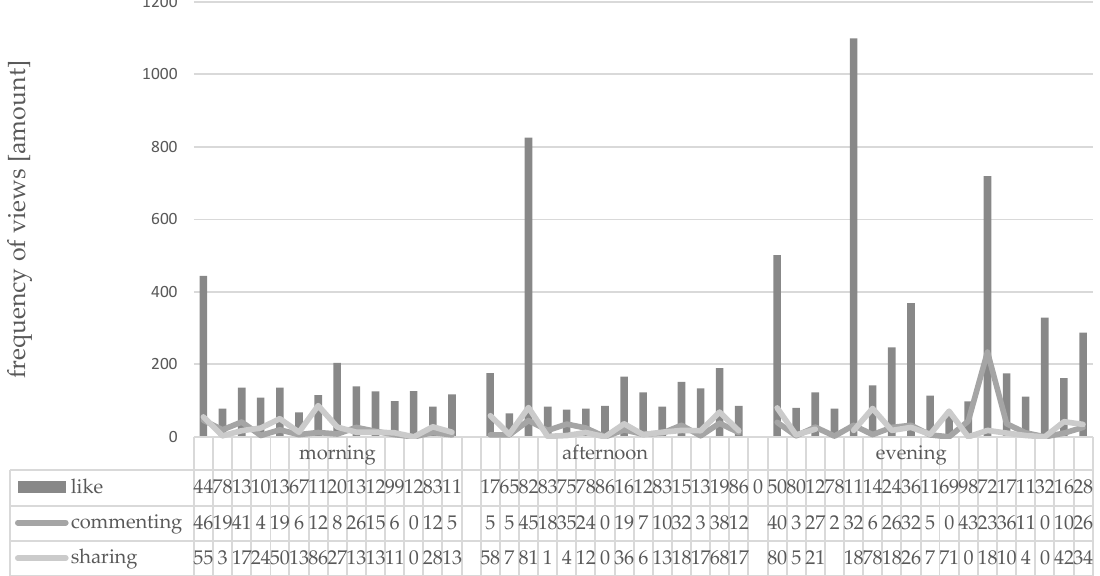
Figure 2. Summary of the intensity of engagement of Facebook users between 1 and 14 July 2018. Source: authors ’ own elaboration based on Facebook data.